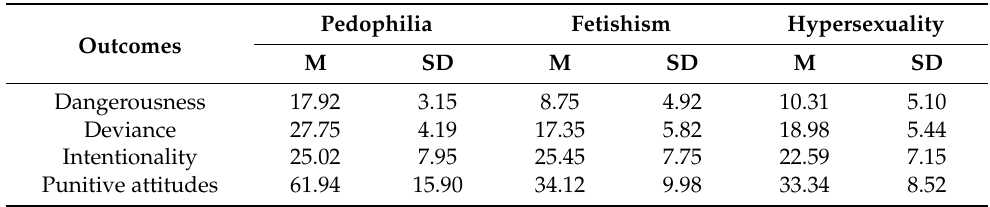
Table 2. Means and Standard Deviations for Stigma and Punitive Attitudes Measures for Pedophilia, Fetishism, and Hypersexuality.